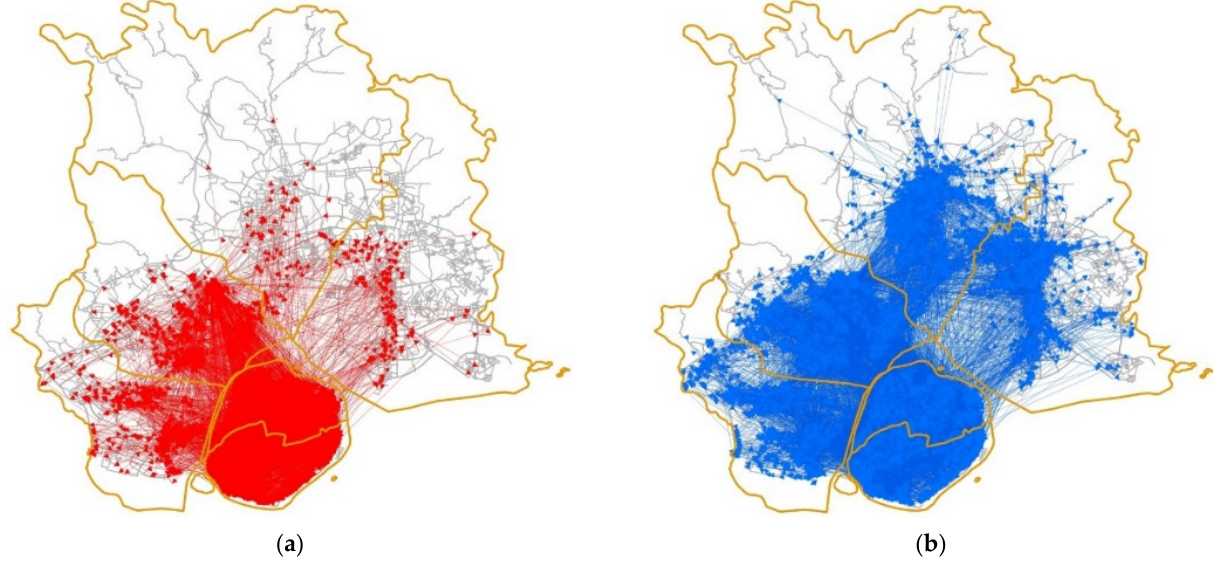
Figure 7. Spatial distribution of taxi flows and ride-hailing flows: ( a ) taxi flows; ( b ) ride-hailing flows.